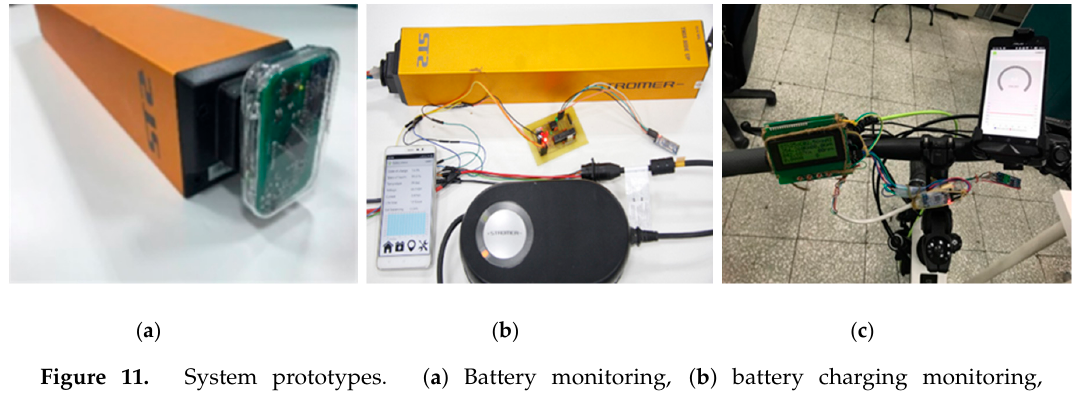
Figure 11. System prototypes. ( a ) Battery monitoring, ( b ) battery charging monitoring, ( c ) e-bike monitoring. Table 3. Transmit process data objects (T-PDOs) of the EnergyBus system simulator.